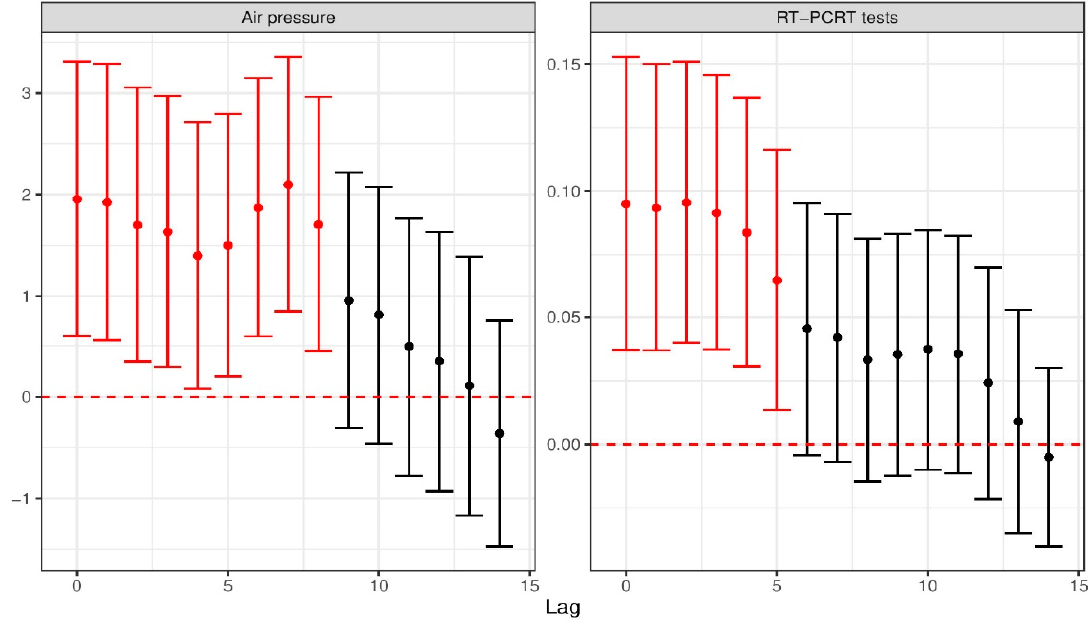
Figure 2. Lagged associations of air pressure and RT-PCR tests on R t . Statistically significant associations are shown in red, whereas null associations are in black. The red vertical dotted line represents the null association. Covariates which showed statistically significant same-day and delayed association with R t were included in the initial full model. Utilizing a stepwise-regression via backward elimination, the final model shown in Table S3, retained same-day (Lag 0) and delayed (Lag 7) air pressure, same-day (Lag 0) RT-PCR tests and the interaction of CQ and time. R t , while exhibiting a statistically positive association with air pressure, was observed to have greater magnitude ( β = 2.59) of increase with same-day air pressure compared to the previous week’s ( β = 2.26), as shown in Table 3. Similar to air pressure, RT-PCR tests showed a positively significant association, albeit with lower magnitude ( β = 0.14). On the other hand, all CQ categories indicated strong evidence of a statistically negative association with R t , except for the first CQ category, which showed marginal statistical